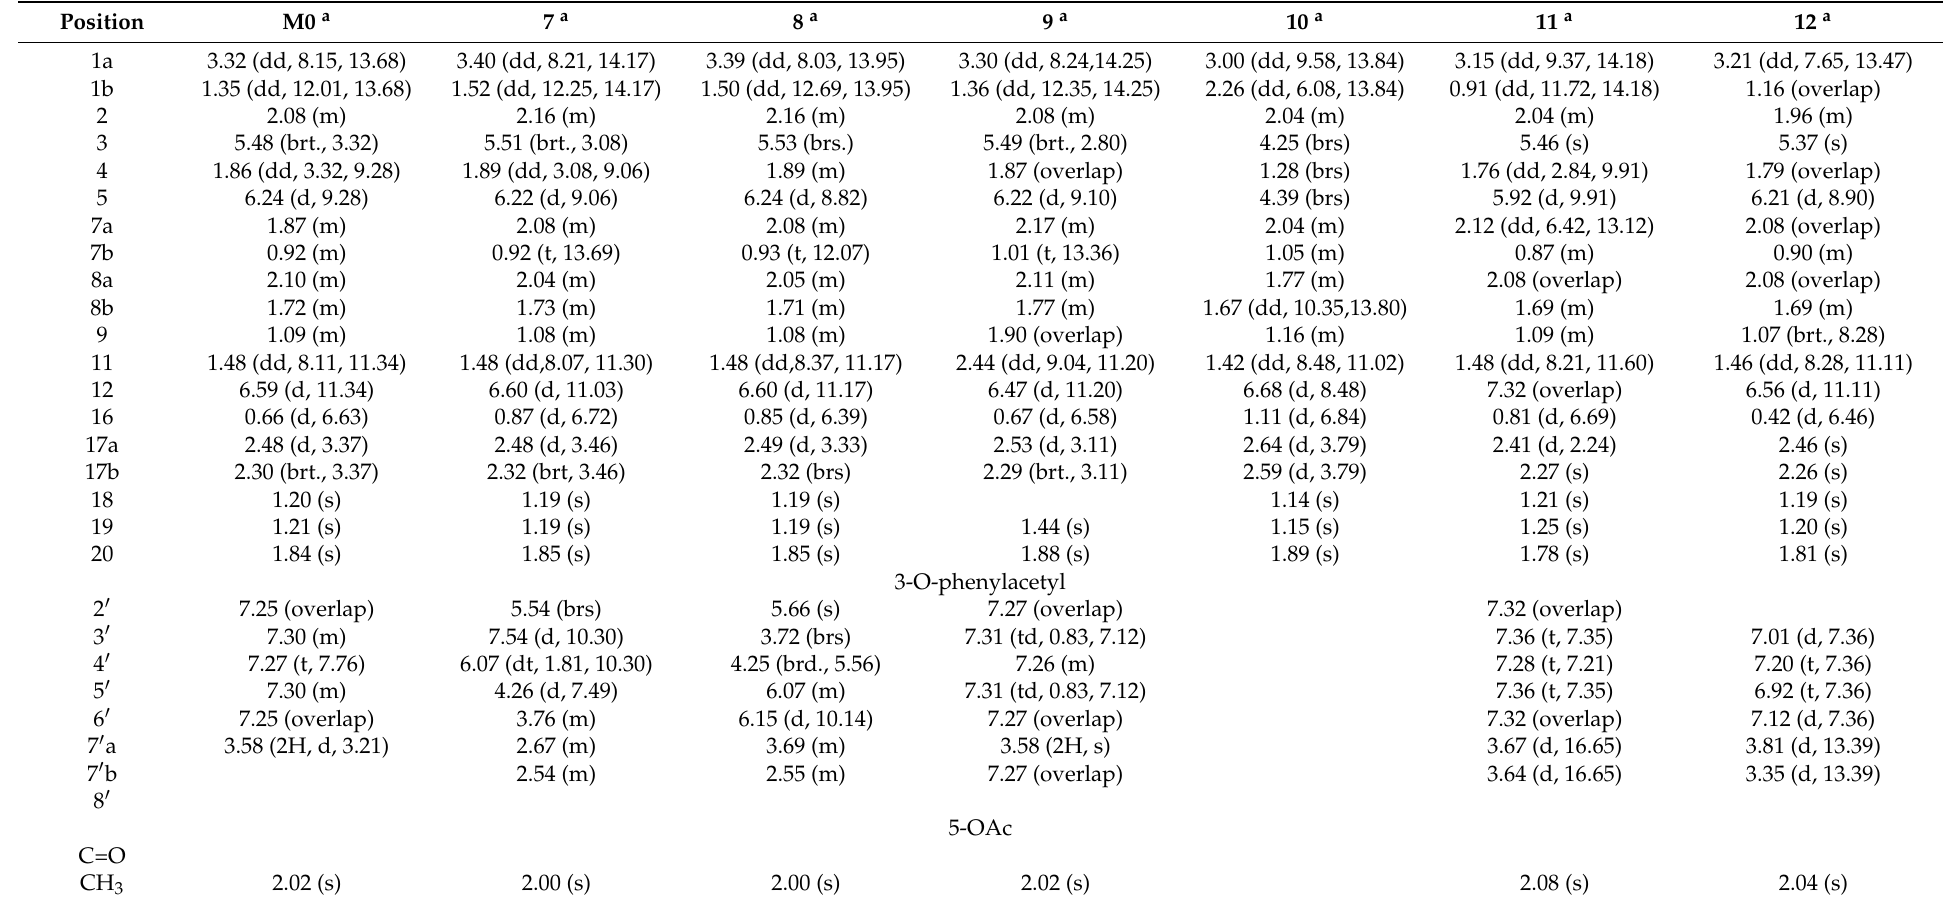
Table 2. The 1 H NMR data for euphorbiasteroid and its transformation products ( 7 – 12